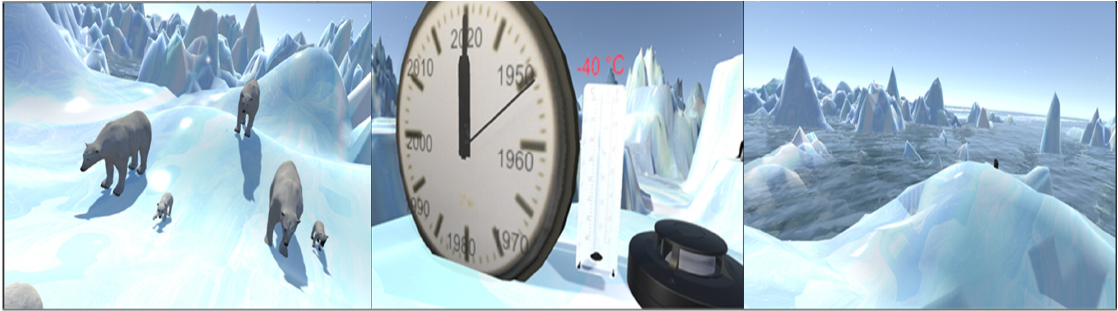
Figure 2. Arctic in the 1950s (left), timer, thermometer, CO2 concentration meter data monitoring in Arctic in the 1950s (middle), Arctic in the 2020s (right).